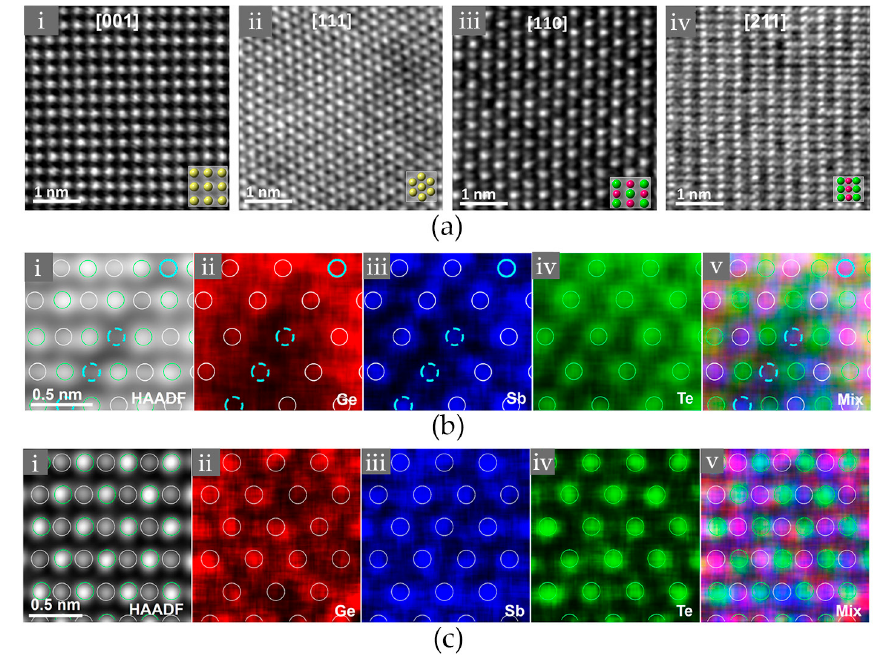
Figure 2. ( a ) The high angle annular dark field scanning transmission electron microscopy (HAADF-STEM) images of Ge 2 Sb 2 Te 5 along the [001], [111], [110], and [211] crystallographic orientations. Insert in the bottom right corner of each image is the arrangement obtained from the ideal atomic model. Yellow color indicates that the atomic column includes both cation-like and anion-like atoms, while pink and green indicate the cation-like and anion-like sublattices, respectively. ( b , c ) The EDX chemical mappings of rocksalt Ge 2 Sb 2 Te 5 along the [110] direction with Ge, Sb and Te being marked in red, blue and green, respectively. The mixture of these mappings is also shown. ( b , c ) Are taken from the different parts of the same sample. Adapted with permission from Reference [42]. © 2016 American Institute of Physics.